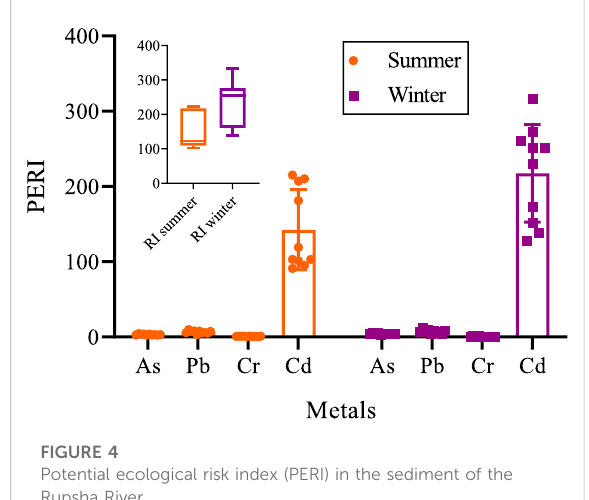
FIGURE 4 Potential ecological risk index (PERI) in the sediment of the Rupsha